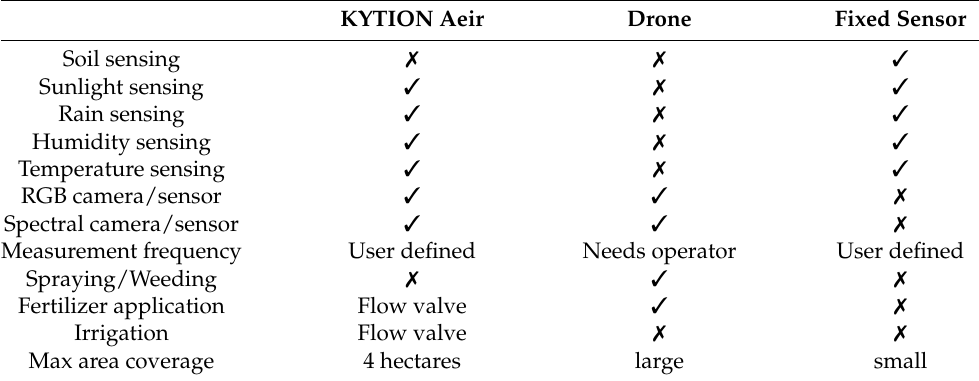
Table 1. KYTION Aeir comparison with drones and fixed sensors. KYTION Aeir Drone Fixed